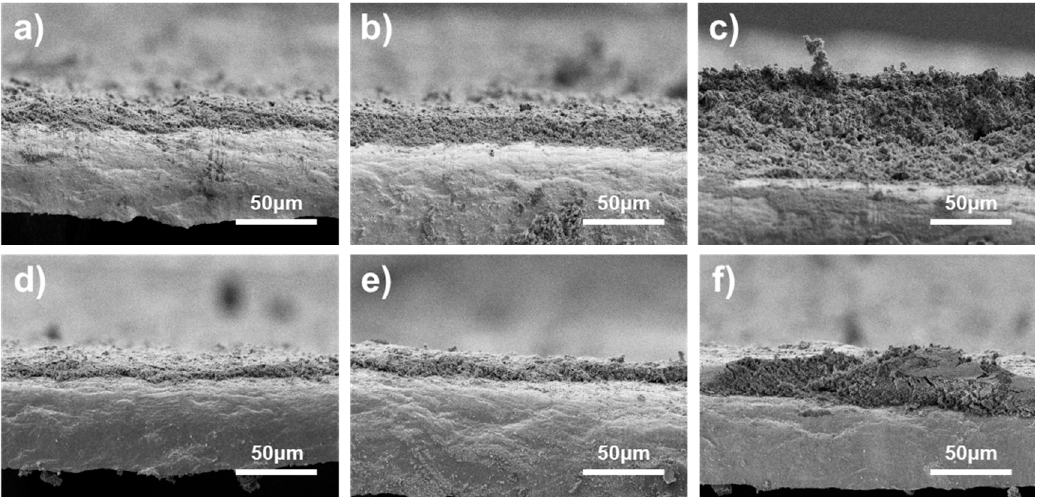
Figure 10. SEM images of the cross section of untreated h-BN coatings under different deposition conditions. ( a ) 15 V 10 min; ( b ) 30 V 10 min; ( c ) 50 V 10 min; ( d ) 30 V 8 min; ( e ) 30 V 12 min; ( f ) 30 V 16 min.